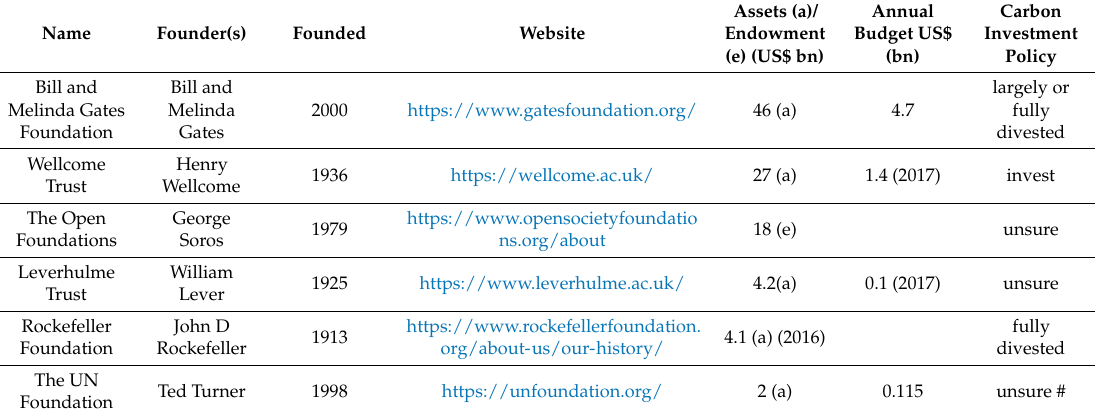
Table 1. Some of the most prominent examples of philanthrocapitalism in the English-speaking world. Key: # My enquiry was